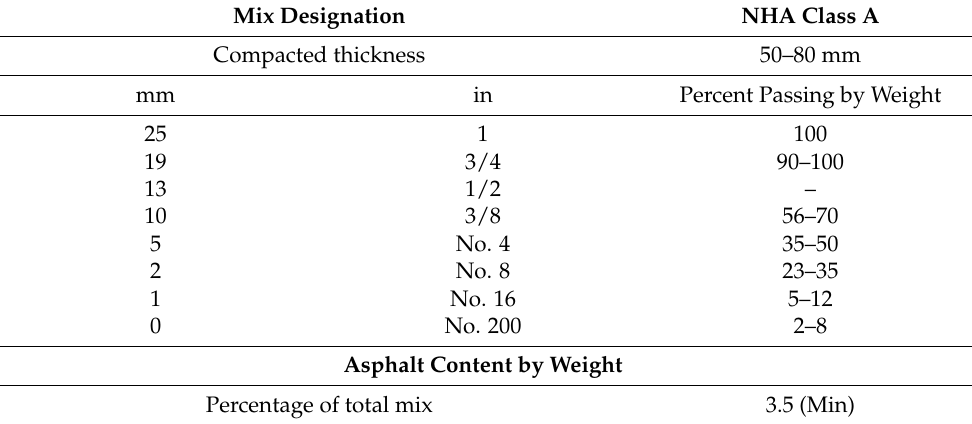
Table 5. National Highway Authority (NHA) class “A” materials selection